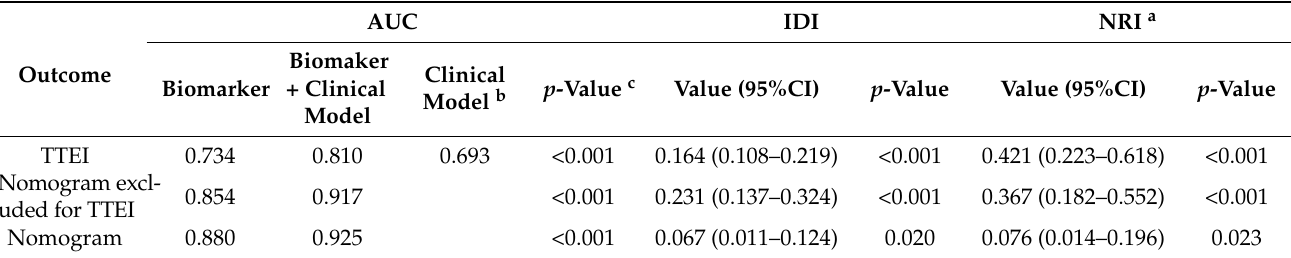
Table 4. NRI and IDI analyses for risk reclassification of CVS −